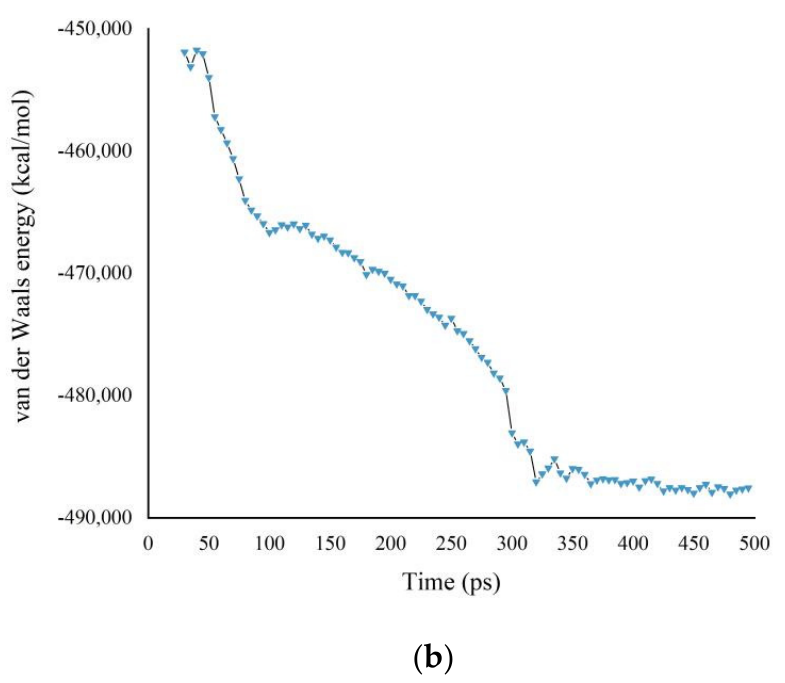
Figure 6. Potential energy of model in the self-healing process. ( a ) Bond energy and angle energy; ( b ) van der Waals energy.